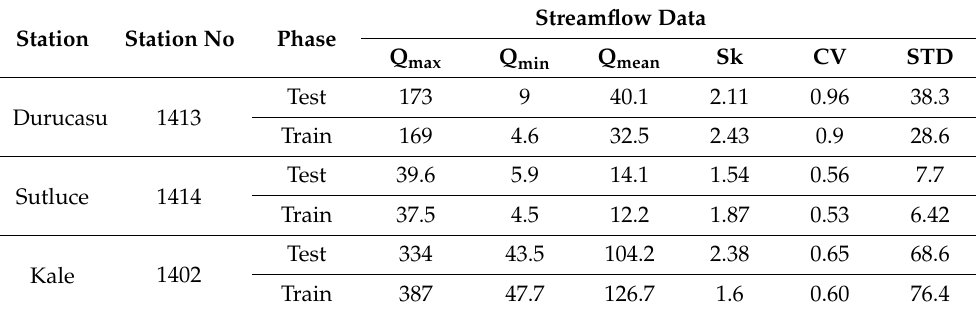
Table 1. Statistical properties of the streamflow